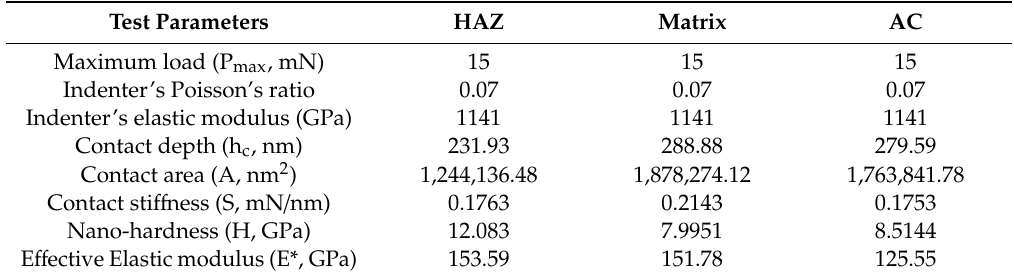
Figure 4. ( a ) Load–displacement curve in different regions of the 1.5 mm sample by 200 W; ( b ) Effective elastic modulus in the different regions near the surface of the 2 mm sample by 200 W. Table 1. Nano-hardness and elastic modulus in the different zones of the 1.5 mm sample by 200 W.